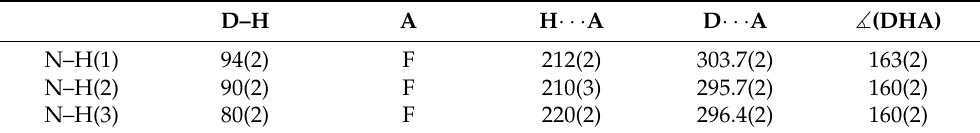
Figure 6. Visualization of the hydrogen bond network in [In(NH 3 ) 6 ][AlF 6 ]. Atoms at the outer edges of the octahedra were omitted for clarity. Table 7. Interatomic distances (in pm) and angles (in deg.) of the hydrogen bonds in [In(NH 3 ) 6 ][AlF 6